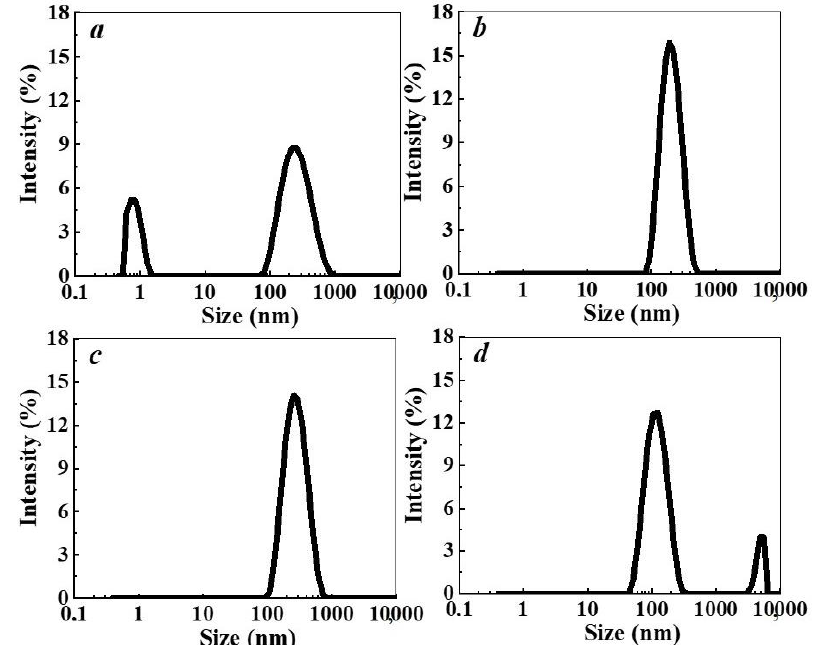
Figure 1. Particle size distribution based on light scattering intensity in the L -Trp systems. Concentration (c, mol/L) of L -Trp as follows: ( a ) 1 × 10 −2 , ( b ) 1 × 10 −4 , ( c ) 1 × 10 −11 , ( d ) 1 × 10 −16 mol/L, 25 °C.